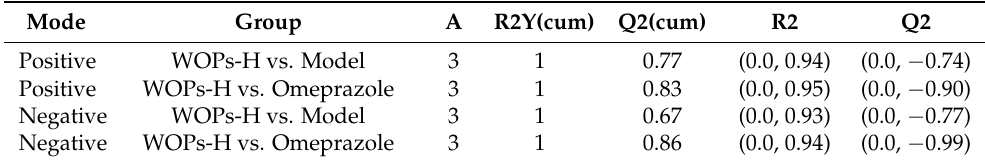
Figure 8. Score chart of PCA analysis model. ( a ) Positive ion mode; ( b ) negative ion mode. PC1 represents the first principal component, PC2 refers to the second principal component, and the number in parentheses is the score of the principal component, which represents the percentage of the overall variance explained for the specific principal component. The ellipses are 95% confidence intervals. Each point represents one sample, with six samples per group, and different groups are labeled with different colors. Table 2. The PLS-DA model parameters.